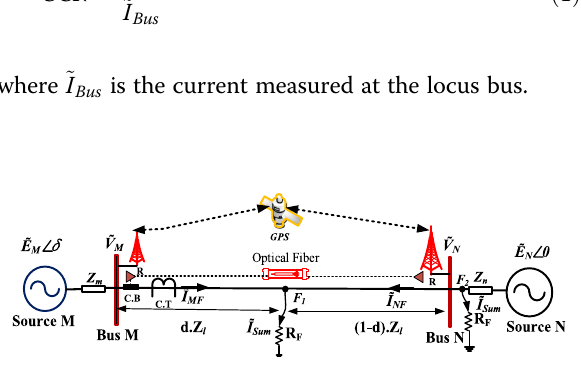
Fig. 1 Single line diagram of the power system network during a fault